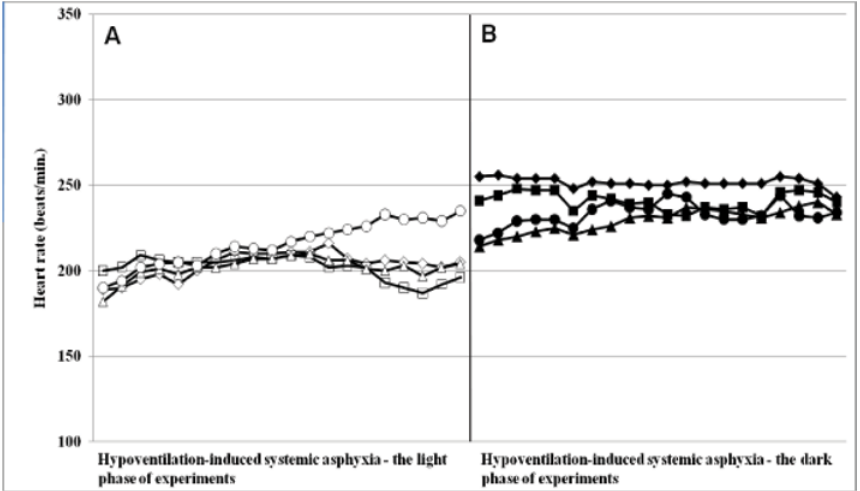
Figure 3. The average heart rate (HR) values during hypoventilation-induced systemic asphyxia in the control group and in the groups pre-treated by a different number of preconditioning (PC) cycles in the light (empty symbols) and the dark (filled symbols) parts of the rat regimen day, respectively. Control group – rhombus; 1PC group – square; 2PC group – triangle; 3PC group –